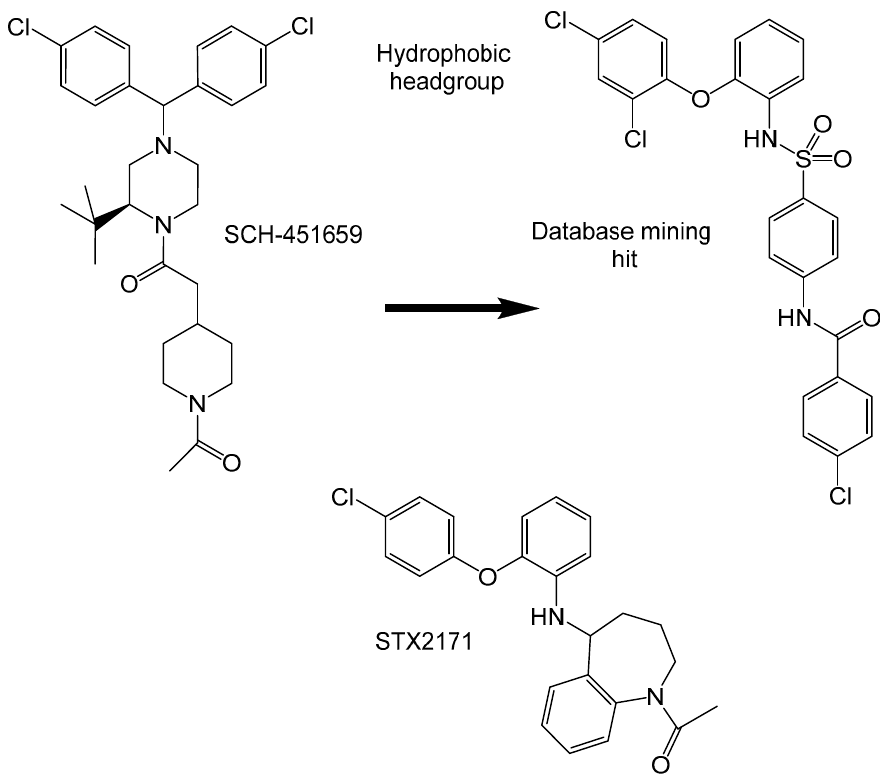
Figure 3. Database mining hit from SCH-451659 and resulting lead STX2171.